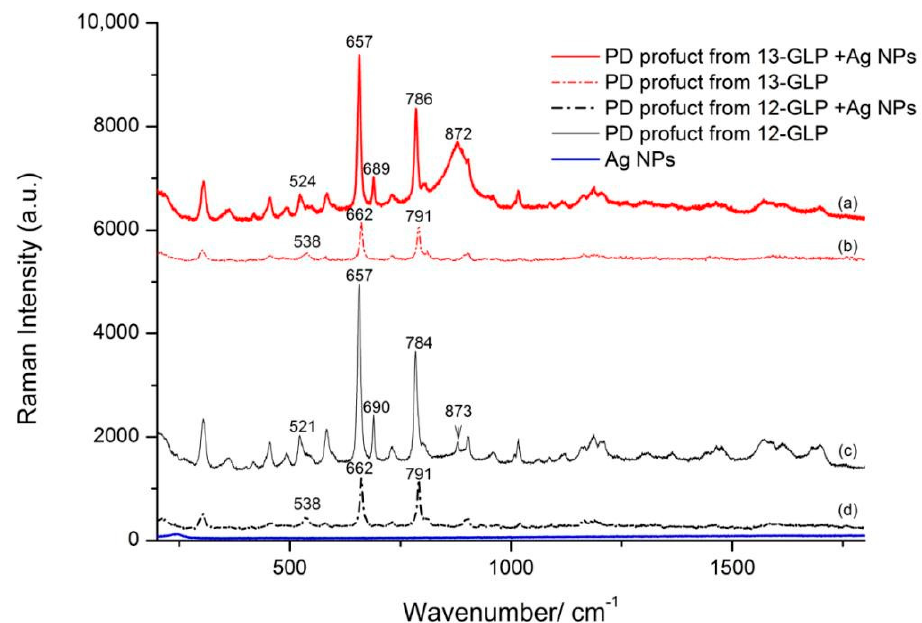
Figure 4. Raman and Surface-enhanced Raman scattering (SERS) spectra absorbed onto Ag NPs of the purple color dye (PD) products from glyphosate (12–GLP) and 2- 13 C-glyphosate (13–GLP) at a concentration of 1.0 × 10 − 3 mol · L − 1 . ( a ) SERS spectra of PD products from 12–GLP ( b ) Raman